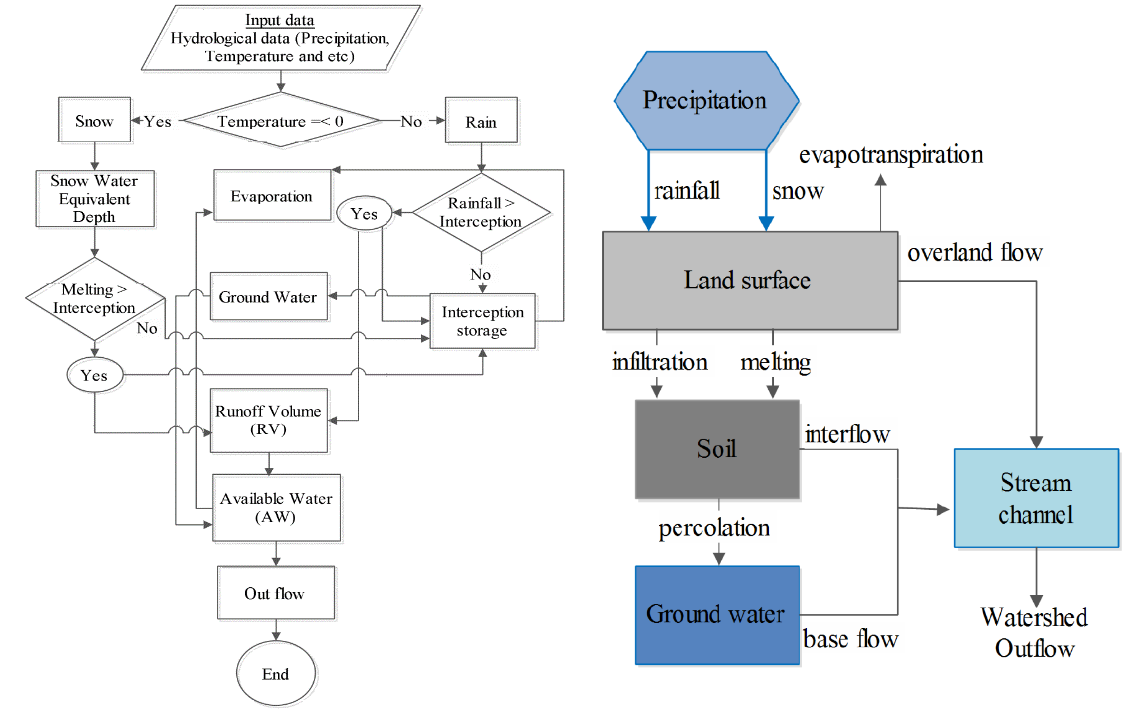
Figure 3. Model Algorithm. Figure 4. Vensim runoff